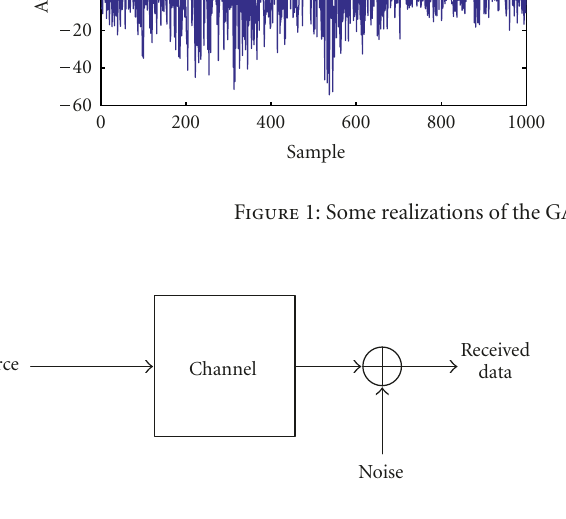
Figure 2: System block-diagram.